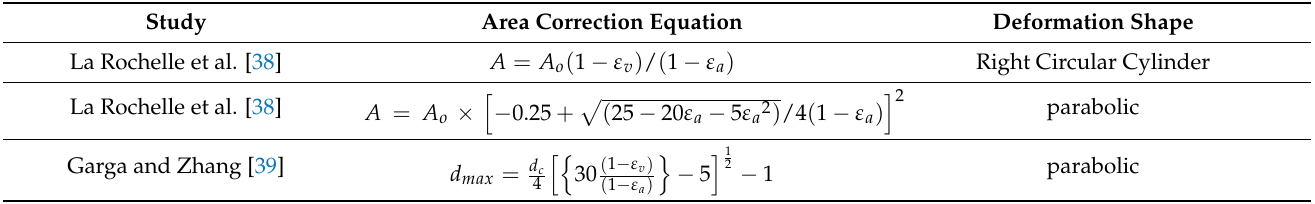
Table 2. Cross-sectional area correction equations reported by different researchers.